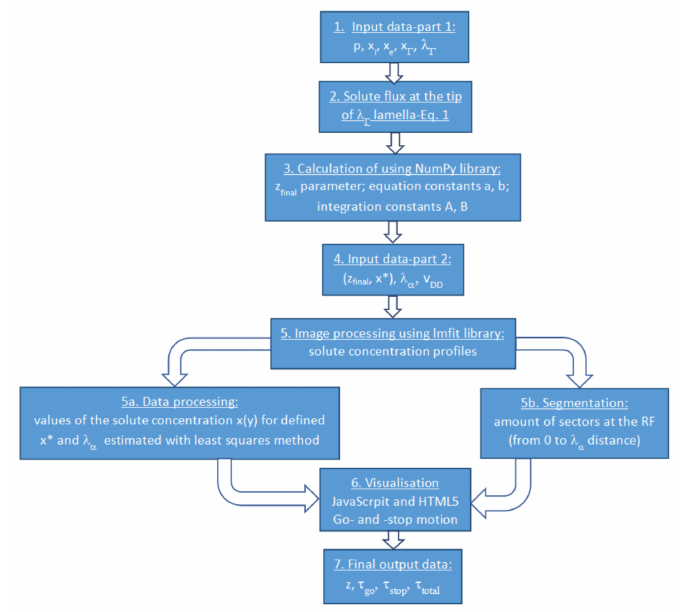
Figure 1. Flowchart of the simulation